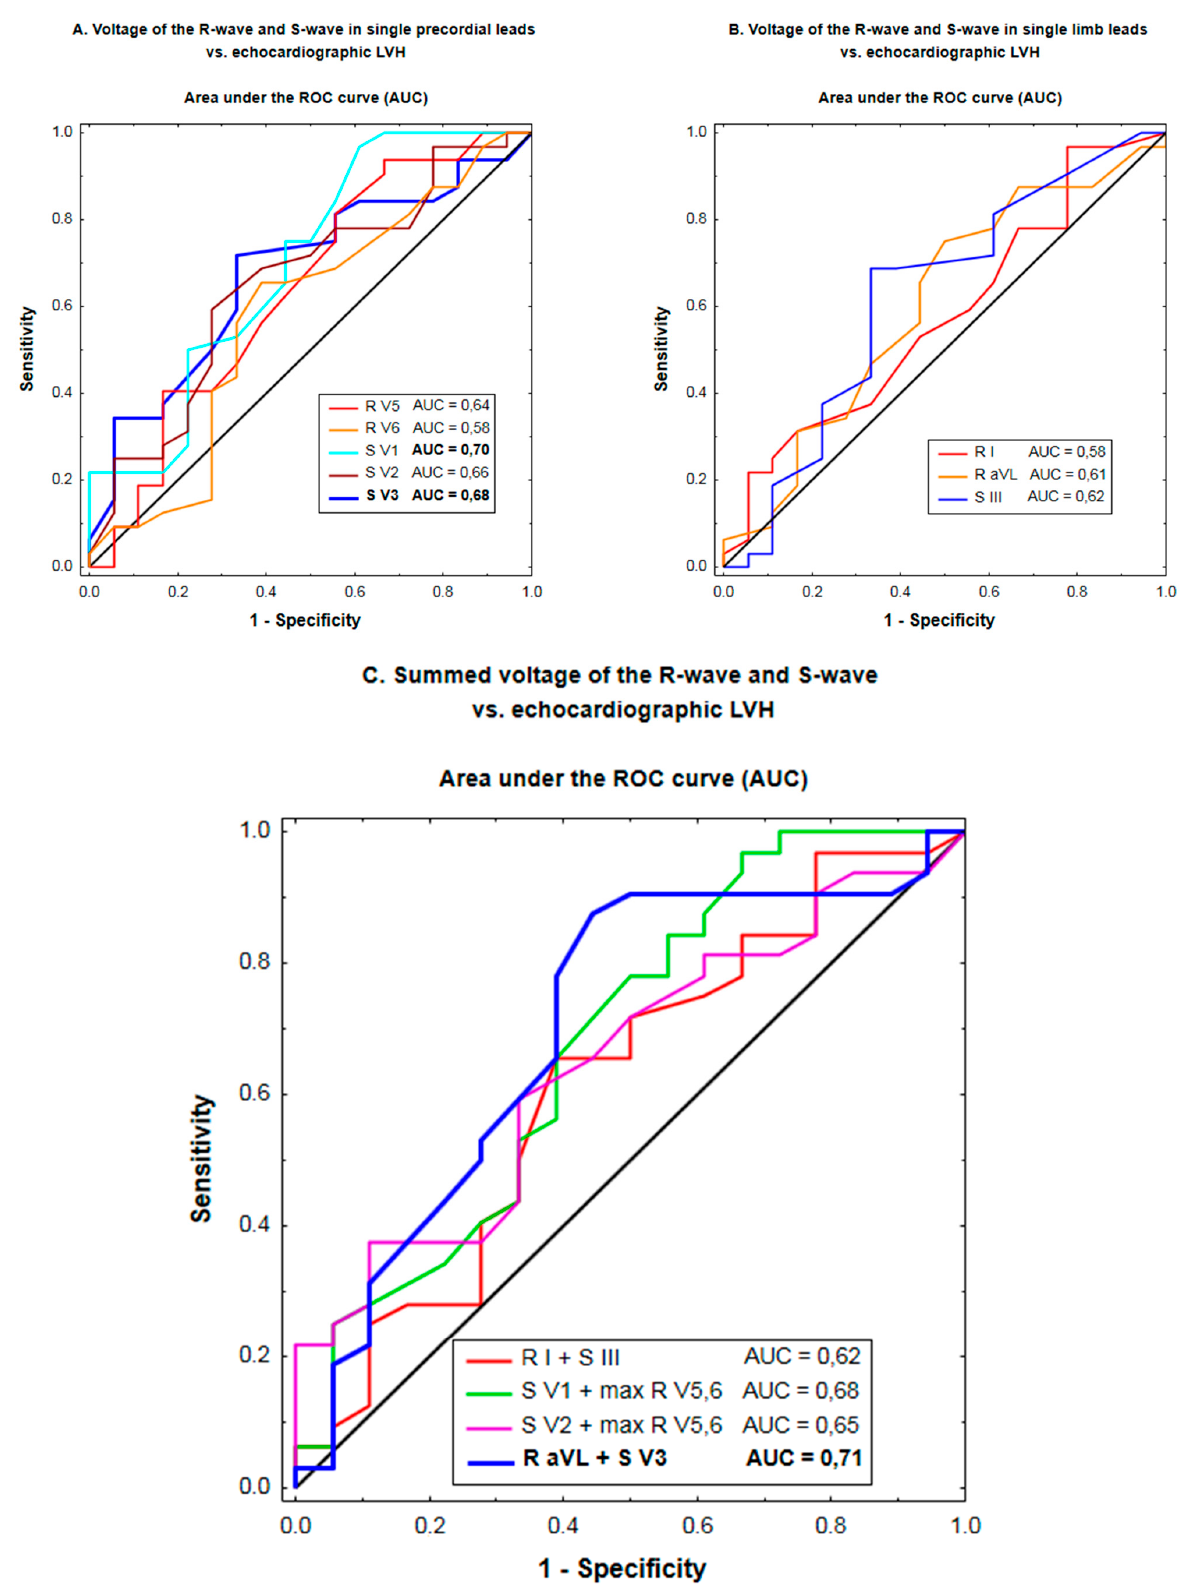
Figure 1. Discriminating ability of the voltage of the R-wave and S-wave in single precordial leads ( A ), single limb leads ( B ), and combinations of the amplitude of R-waves and S-waves ( C ) for the prediction of echocardiographic LVH according to the receiver operating characteristic (ROC) curve analysis. p -values below 0.05 are denoted in